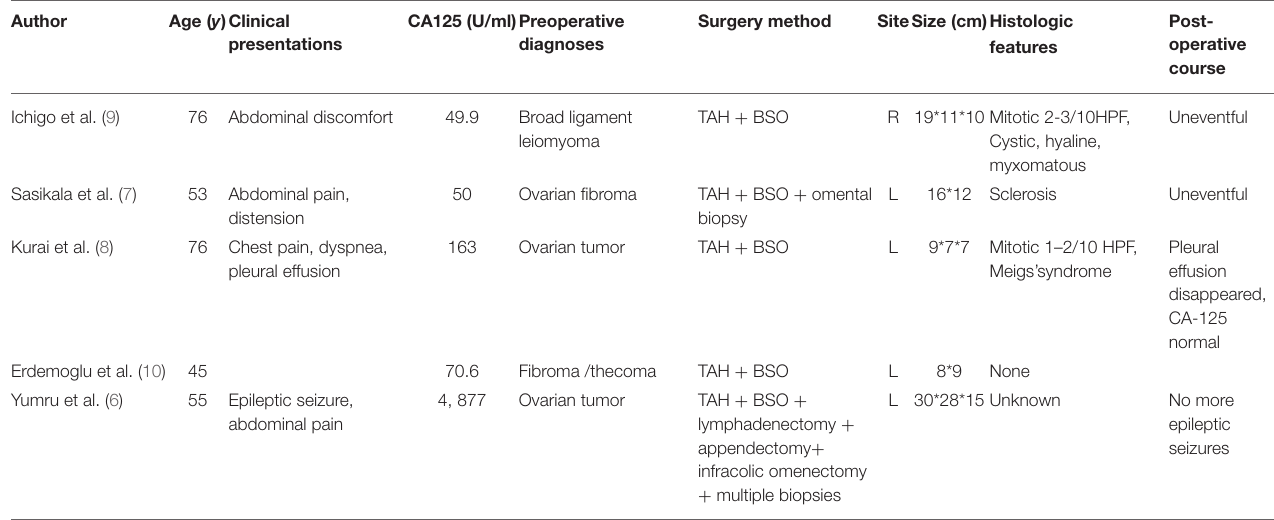
TAH, total abdominal hysterectomy; BSO, bilateral salpingo-ophorectomy; R, the right ovary; L, the left ovary.